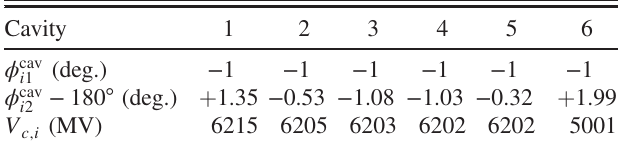
TABLE II. Effective cavity ( ϕ cav ij ) phases and cavity voltages for near energy balanced configuration used for ER measure-